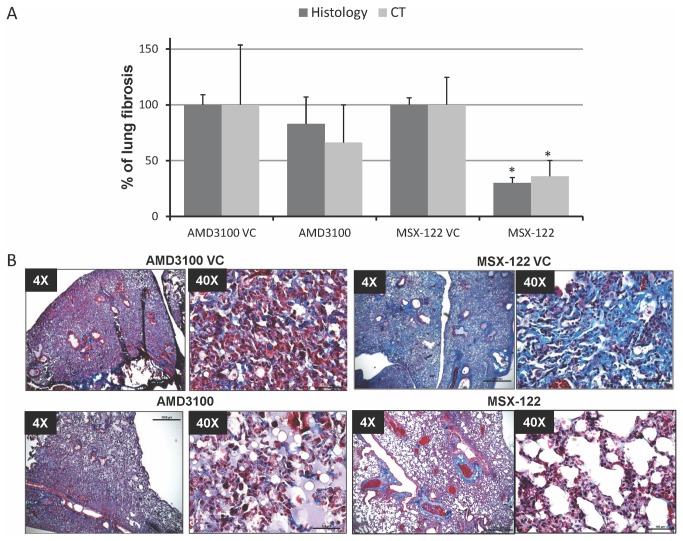
CXCR4 antagonists inhibit radiation-induced PF.Mice underwent hemithoracic irradiation (20-Gy) and treated with CXCR4 antagonists or their corresponding vehicle controls (n=10/group). A, Lungs were evaluated histologically after trichrome staining (dark bars) or by CT scan (light bars) at 20-weeks post-irradiation. Histologic evaluation was scored (0-12) in each lung as described in the Methods section. CT scan evaluation was scored as the percent volume of lung with density>-200 HU. In all assessments, the vehicle controls values were normalized to 100% with drug-treated values expressed relative to corresponding controls to evaluate the efficacy of the CXCR4 antagonists in attenuating radiation-induced PF. Error bar represents SEM. * indicates statistically significant difference (p<0.05) compared with vehicle controls. B, Representative micrographs of trichrome staining are shown in 4X and 40X magnification.